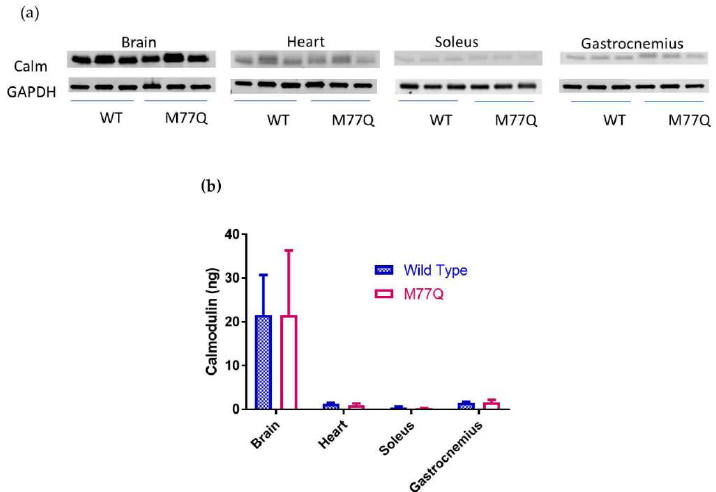
Figure 2. Measurement of total tissue calmodulin in 3 male mice. ( a ) Western blots; ( b ) Quantitation of blots. The abbreviations are Calm, calmodulin and WT, wild type.